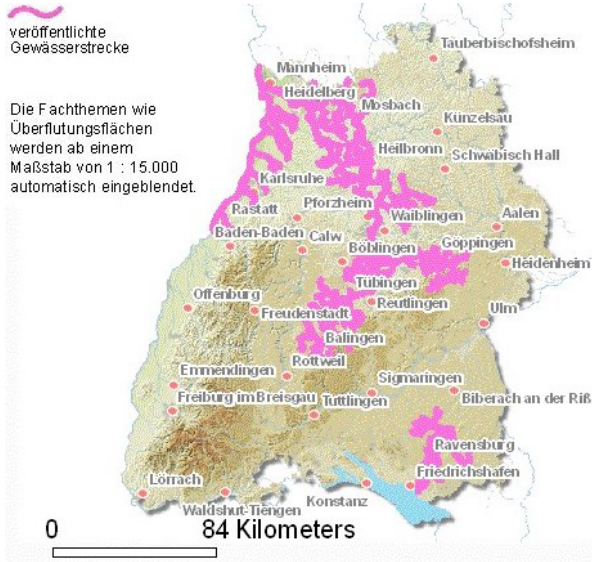
Fig. 3. Overview map of the water stretches in Baden- W¨urttemberg for which flood hazard maps could be viewed in March 2013. Graphic from the online map service available from the Ministry of the Environment (http: //rips-dienste.lubw.baden-wuerttemberg.de/rips/hwgk internet/